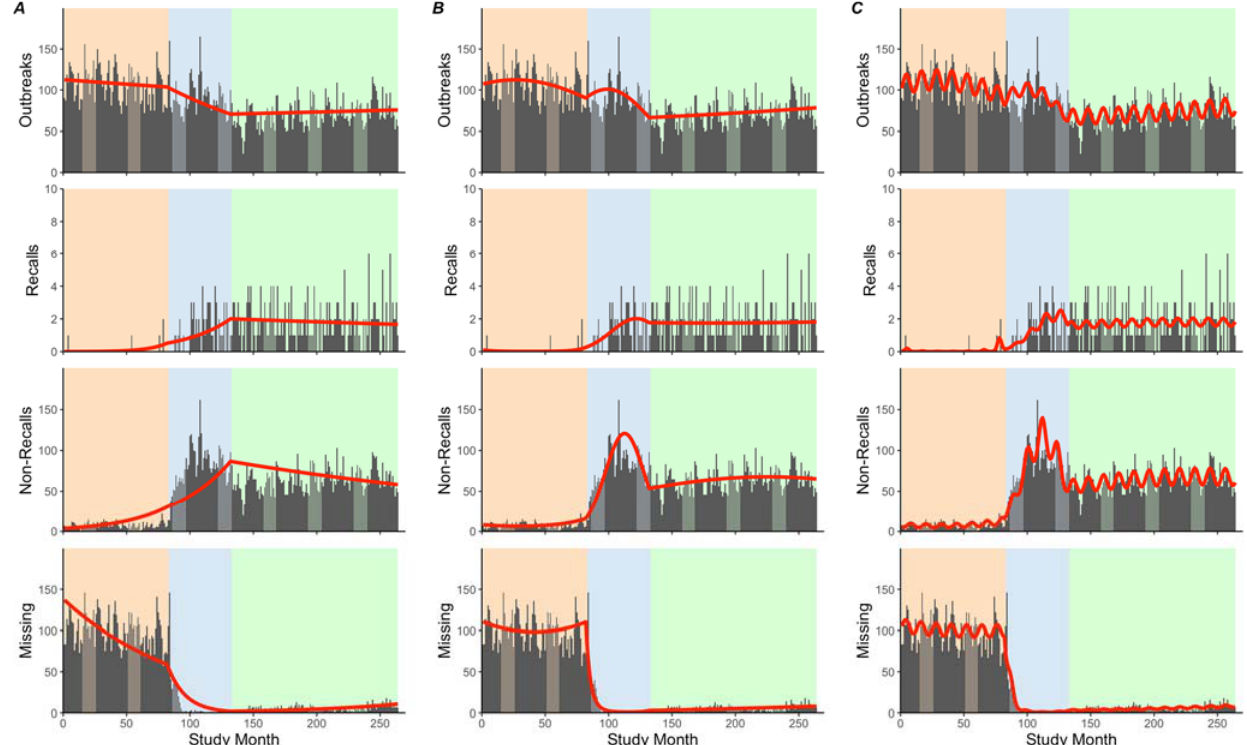
Figure 1. Stacked time-series plots of monthly outbreaks, recalls, non-recalls, and outbreaks with missing recall information (top to bottom rows, respectively), as reported by the electronic Foodborne Outbreak Reporting System (eFORS) and National Outbreak Reporting System (NORS) in 1998–2019. We present segmented time-series model results, adjusting for linear trends only (Model 3; Panel ( A )); linear and quadratic trends (Model 4; Panel ( B )); and linear, quadratic, and harmonic trends (Model 5; Panel ( C )). Within each plot, we report observed counts (gray bars) with fitted model results (red lines) and indicate critical periods by using different background colors.